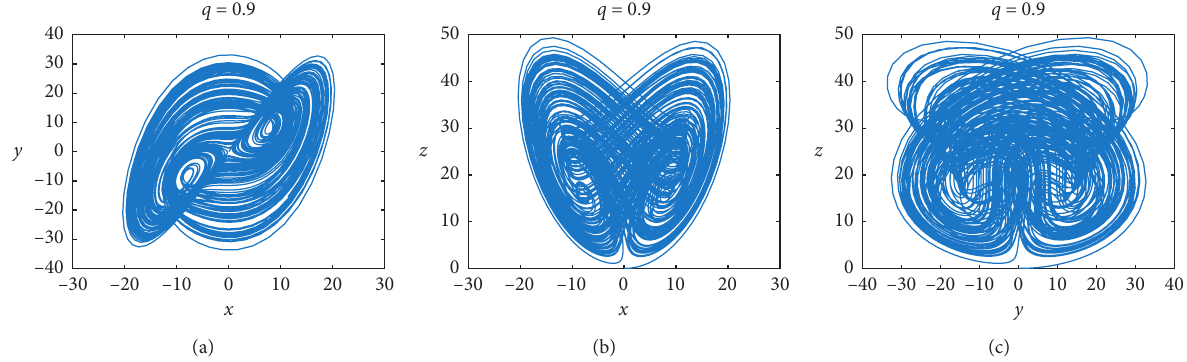
Figure 2: The chaotic attractor of system (1) with q � 0.9. (a) x - y plane, (b) x - z plane, and (c) y - z plane.